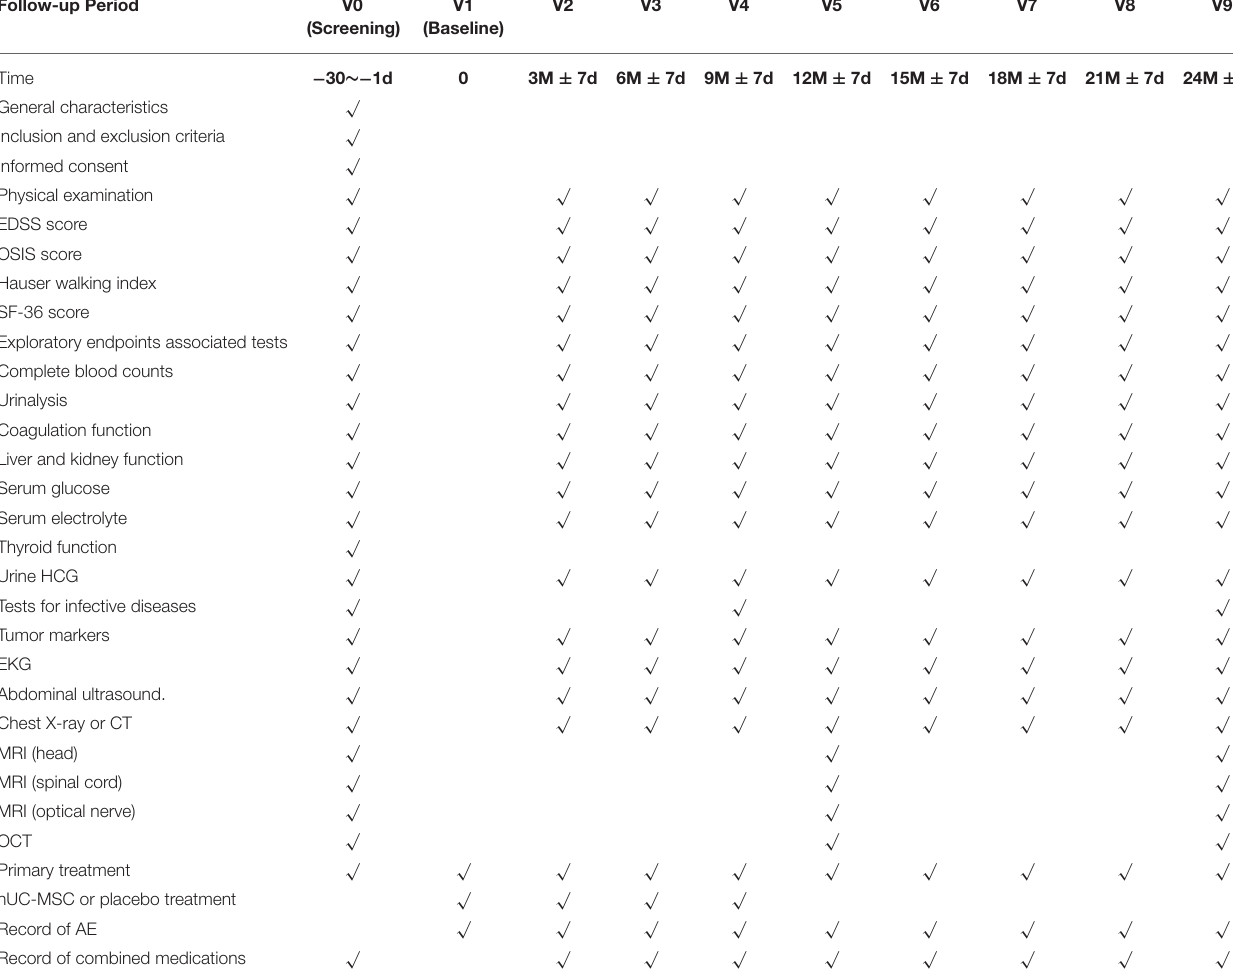
TABLE 1 | Schedule of activities of human umbilical cord mesenchymal stem cells (hUC–MSCs) to treat neuromyelitis optica spectrum disorder (hUC–MSC–NMOSD) study. Follow-up